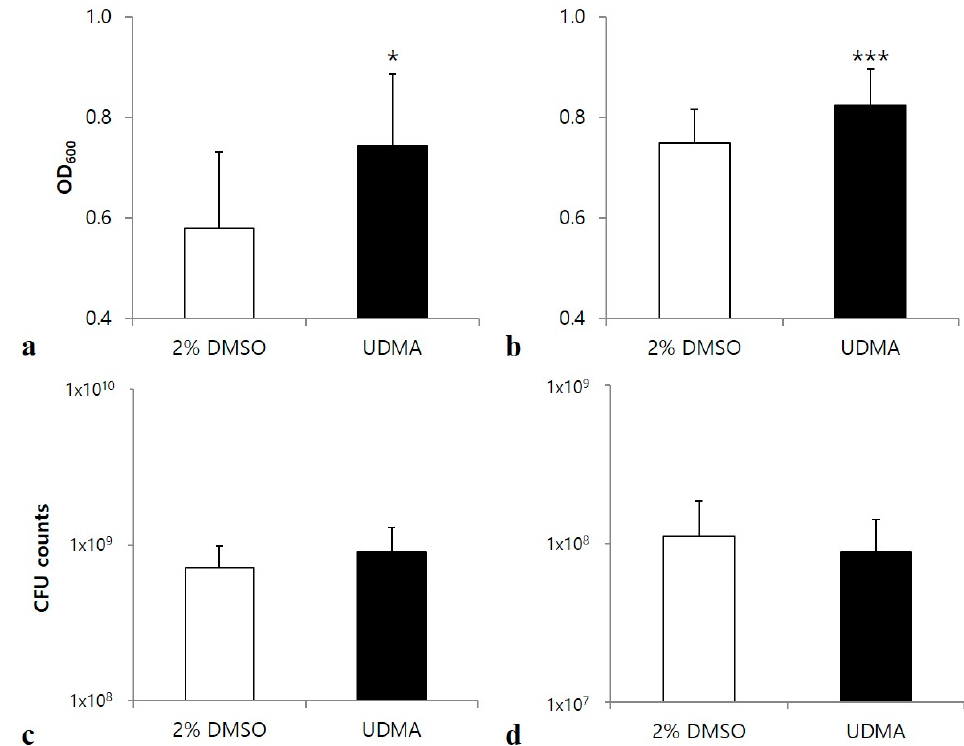
Figure 3. Development of biofilms of S. mutans UA159 grown in the presence and absence of UDMA on saliva-coated surfaces for 24 h. Absorbances were determined through the crystal violet assay of biofilms grown in a medium supplemented with glucose ( a ), or sucrose ( b ). Viable cells were counted after the cell growth in a glucose-containing medium ( c ), or sucrose-containing medium ( d ). DMSO was used as a vehicle for UDMA, and the cells grown in the absence of UDMA (2% DMSO) were used as the control. The data are expressed as the mean ± standard deviation values. * p < 0.05, *** p < 0.001; Mann–Whitney U test.